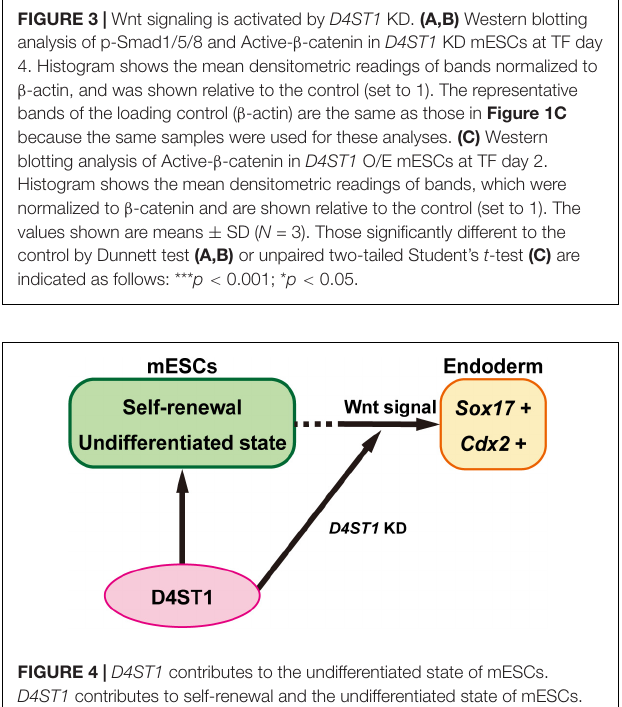
FIGURE 4 | D4ST1 contributes to the undifferentiated state of mESCs. D4ST1 contributes to self-renewal and the undifferentiated state of mESCs. Knockdown of D4ST1 causes promotion of endodermal differentiation by activation of Wnt